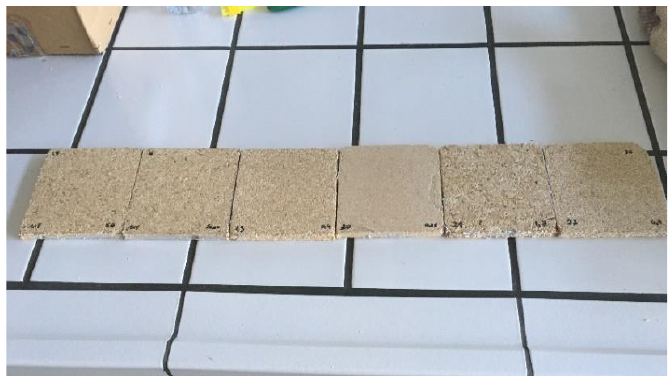
Figure 3. Paulownia tomentosa particleboard boards.